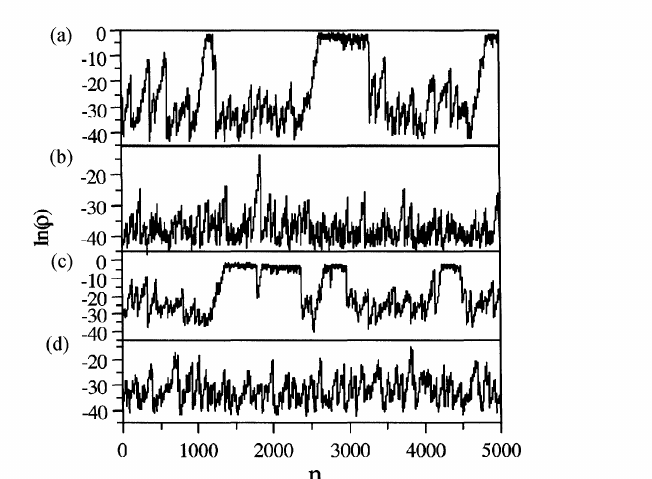
FIGURE 7 (a-d) Plots of the number of iterations versus the logarithm of the average absolute difference p under the perturbation E (--10-18,10-18). Both the two identical subsystems are simulated with e --0.25, p 0.8. (a) The number of dimension of two subsystems is M=4 and 6=0.01. The synchronization is destroyed. (b) With M=4 and 6--0.02, the synchronization is robust. (c) M= 10 and 6= 0.02, the synchronization is destroyed. (d) M-- 10 and 6 0.03, the synchronization is robust